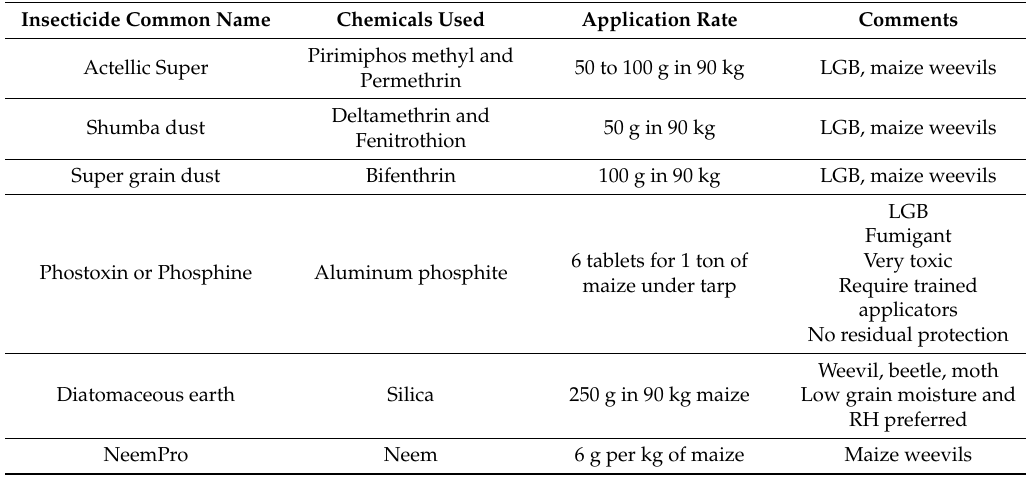
Table 4. Insecticides used during grain storage in developing countries